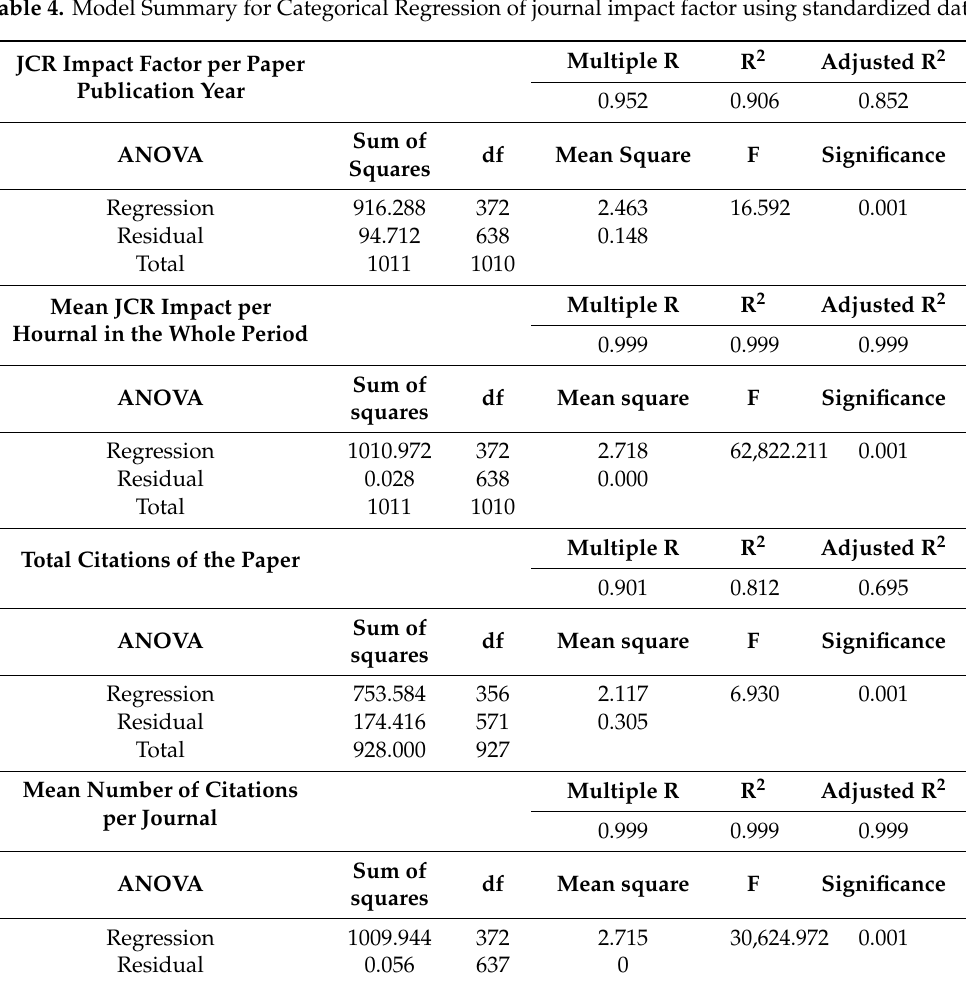
Table 4. Model Summary for Categorical Regression of journal impact factor using standardized